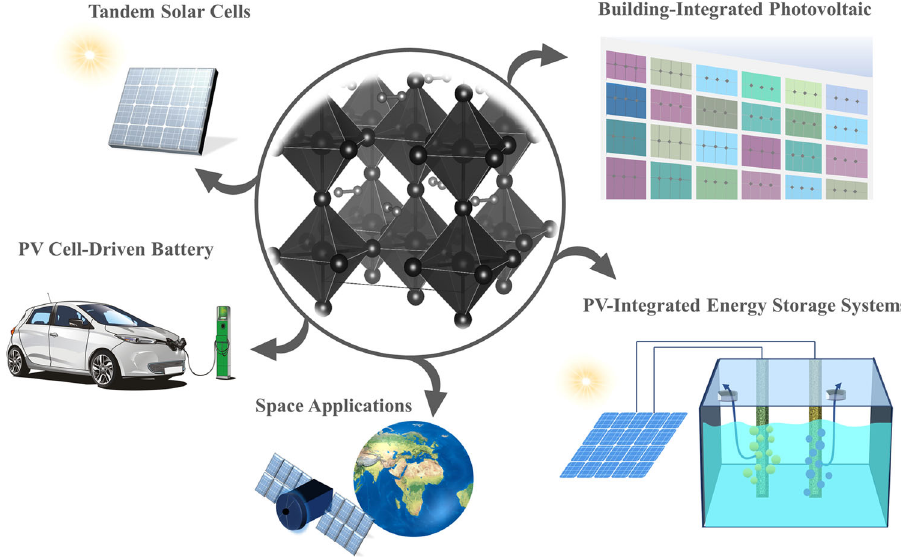
Fig. 1 Schematic overview of the topics covered in this Review. The fi gure outlines the development of halide perovskite materials-based